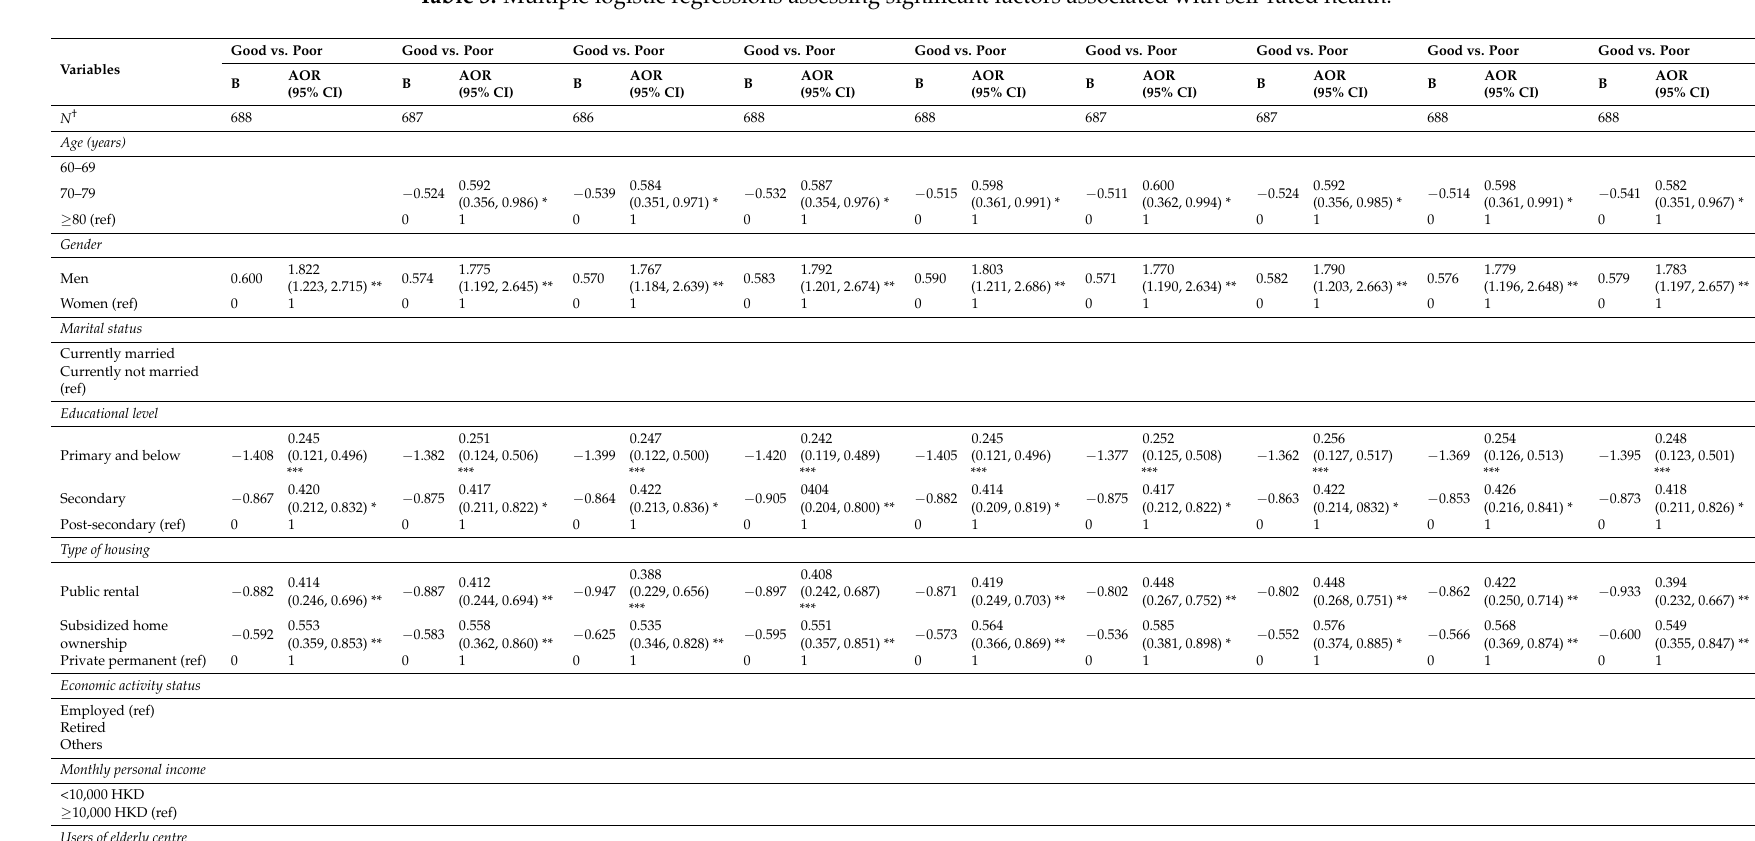
Table 3. Multiple logistic regressions assessing significant factors associated with self-rated